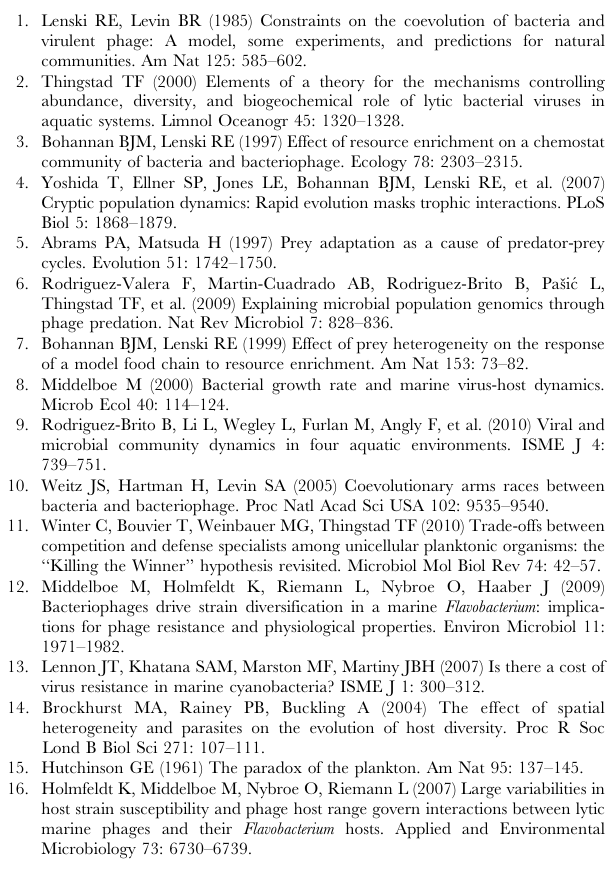
temperatures are used for that primer pair. ‘X’ and ‘NA’ as in Figure 1. Sequenced refers to those strains that were fully sequenced and CRISPR spacer sequences were determined without PCR. Table S1 Pairs of independently acquired spacers match the same virus or plasmid. Each spacer pair is numbered and spacer names are given as an isolate number followed by a locus position number as in Figure 2. In the case of a spacer being ancestrally identical to other spacers, the first (top) spacer from Figure 2 is listed here, though all spacers have a N in Figure 2. * indicates spacer pair from isolates with similar CRISPR arrays. Table S2 Isolation methods for S. islandicus isolates. Isolates are listed with their isolation method. There are seven different isolation methods that yielded colonies: DT (dextrin and tryptone) spread plate as described in [43]; DT overlay plate containing DT media plus an overlay of 0.002% Gelrite (Sigma), 0.002% K2SO4, and 0.002% L-glutamic acid; DTS spread plate containing standard DT media plus an overlay of 0.006% Gelrite and 0.002% colloidal sulfur; DTS overlay plate containing DTS plus additional overlay described above. 1:50 indicates a 1:50 dilution of sample prior to plating. Table S3 MLSA primers. MLSA loci and primers listed with annealing temperature (T) and length of amplicon. * indicates loci used in [28].